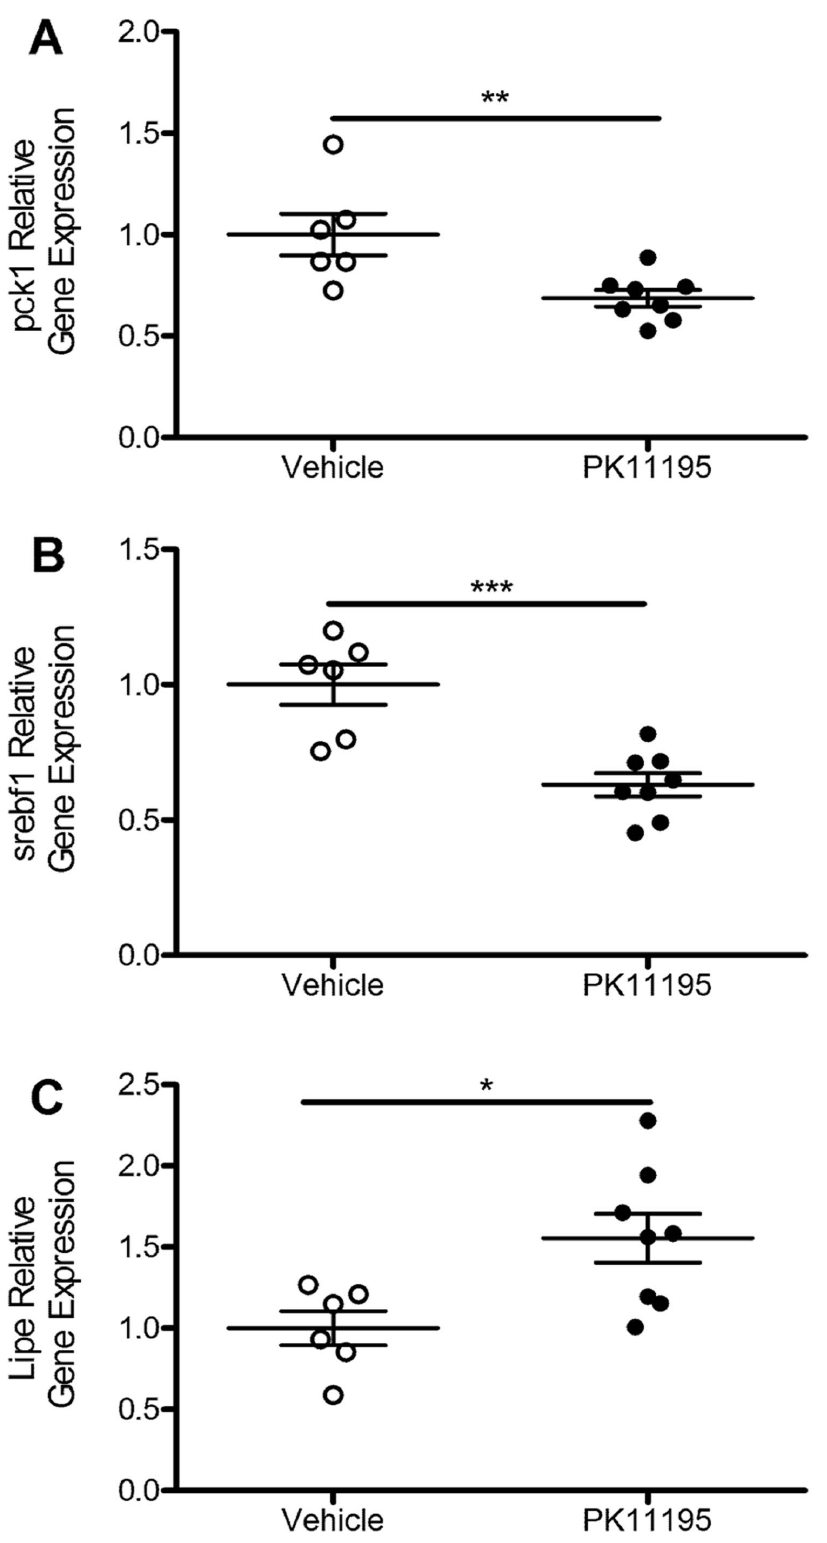
Figure 7. TSPO ligand PK11195 treatment alters mouse WAT metabolic gene expression. Intraperitoneal administration of PK11195 (5 mg/kg) in 8–10 week-old male C57BL/6 mice significantly decreased the expression of pck1 (A) and srebf1 (B) genes in WAT and significantly increased the lipe gene expression (C) as compared to vehicle-treated controls. Data are expressed as mean 6 standard error. n=6–8 for each treatment group. Statistical significance of *p , 0.05, **p , 0.01, and ***p , 0.001 was determined by unpaired t-test.